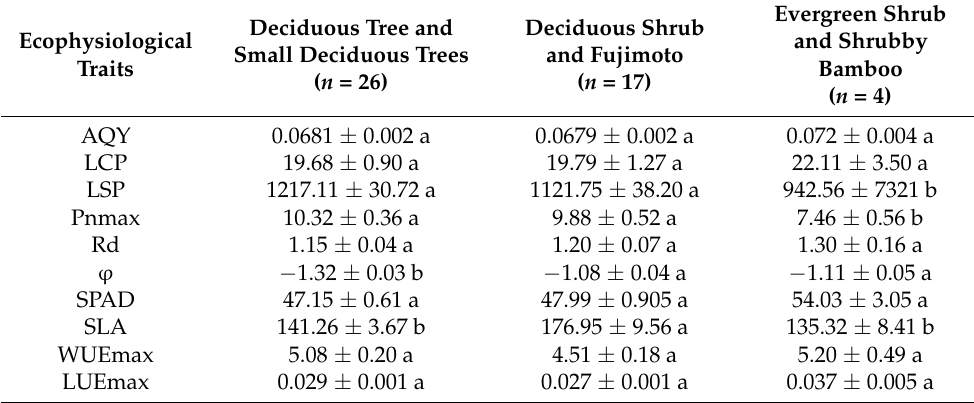
Table 3. Results of a one-way ANOVA of ecophysiological traits of species in different life forms. The values were ecophysiological indicators for three life forms (mean ± SE), different lowercase letters indicate significant differences between different life forms for the same parameter ( p < 0.05). n represents the number of woody species. Abbreviations are shown in Table 1.